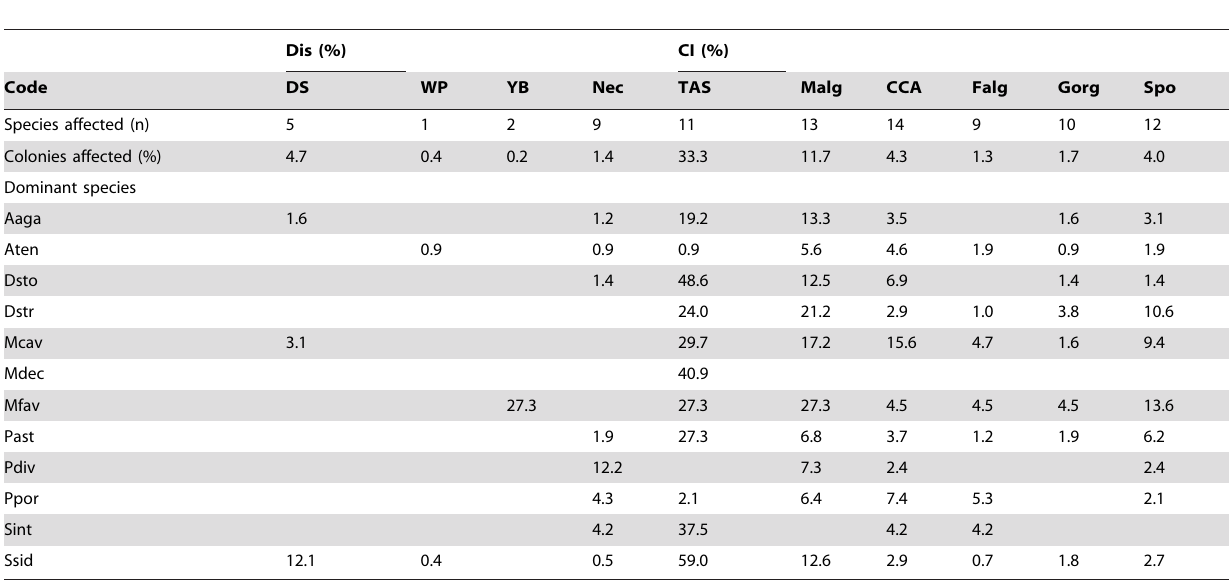
Table 3. Percentage of Scleractinian colonies affected by diseases (Dis) and involved in competitive interactions (CI) in Xcaret in